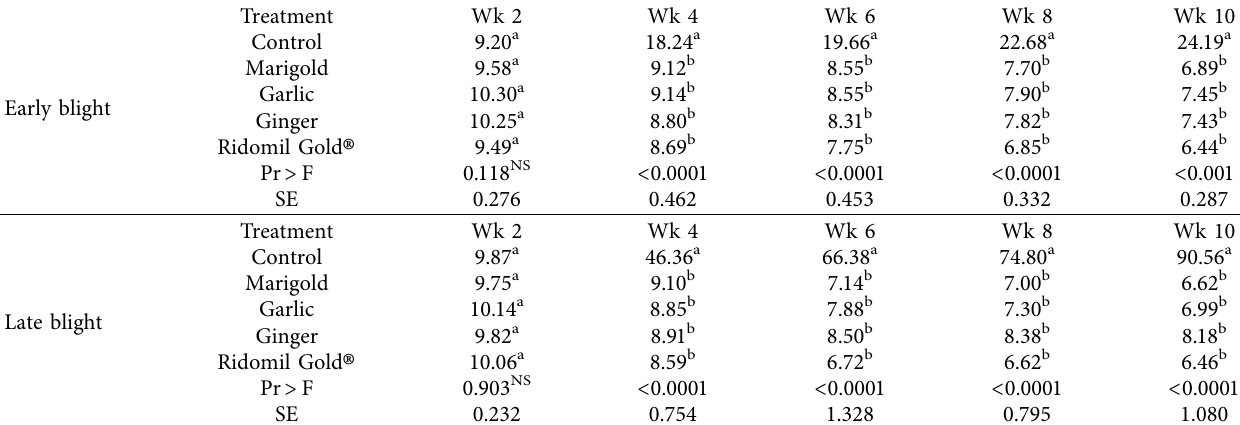
Table 2: Disease severity on inoculated tomato plants.